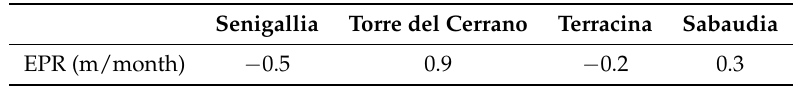
Table 6. Net shoreline displacement rates (as end point rates) at Senigallia, Torre del Cerrano, Terracina and